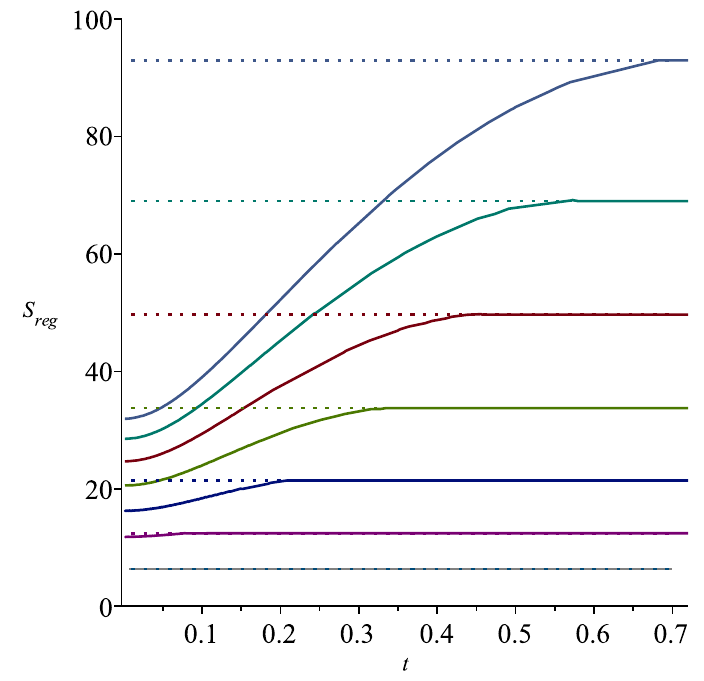
Figure 3 . Time-dependence of subsystem entanglement entropy for a (cid:12)ve-dimensional black hole microstate modeled by a constant tension ETW brane behind the horizon. Curves from bottom to top correspond to successively larger ball-shaped subsystems on the sphere. For large enough subsystems, the minimal area extremal surfaces probe behind the horizon for an interval of